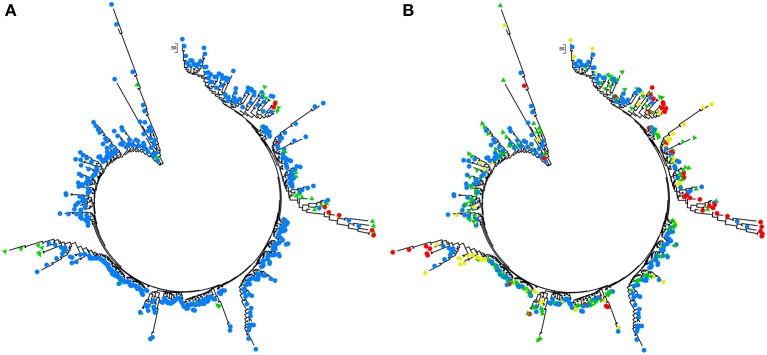
Analyses of phylogenetic association in the 253 Alternaria alternata multilocus genotypes detected from the 725 isolates sampled from China with Nei's genetic distance calculated with GENALEX 6.5. (A) The association between multilocus genotypes and the clusters assigned by admixture analysis with Structure. Colors represented the multilocus genotypes isolates from different clusters and (B) the association between multilocus genotypes and their geographic origins. The phylogenetic trees were reconstructed using Mega 5 and colors represent different clusters or geographic origins. Red, yellow, green, and blue represented the multilocus genotypes isolates from SWR, SMR, CDR, and NSR, respectively.